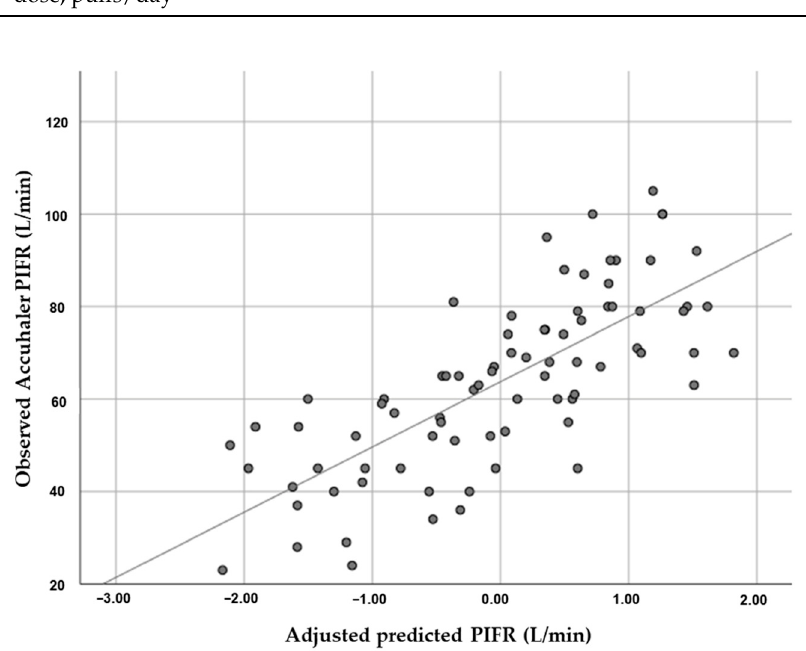
Figure 2. Linear regression analysis showed the correlation between peak inspiratory flow rate (PIFR) for Accuhaler and hand grip strength (HGS) adjusted by age, height, forced vital capacity (FVC), and short-acting bronchodilator dose. Predicted Accuhaler PIFR (L/min) = − 30.340 + (0.274 × hand grip strength) − (0.206 × age) + (0.219 × height) + (1.019 × FVC). The equation for predicting Turbuhaler PIFR, derived from the linear regression model, predicted Turbuhaler PIFR (L/min) = 56.196 + (0.321 × hand grip strength) − (0.196 × female) − (0.224 × age) + (0.304 × FVC) (Table 4 and Figure